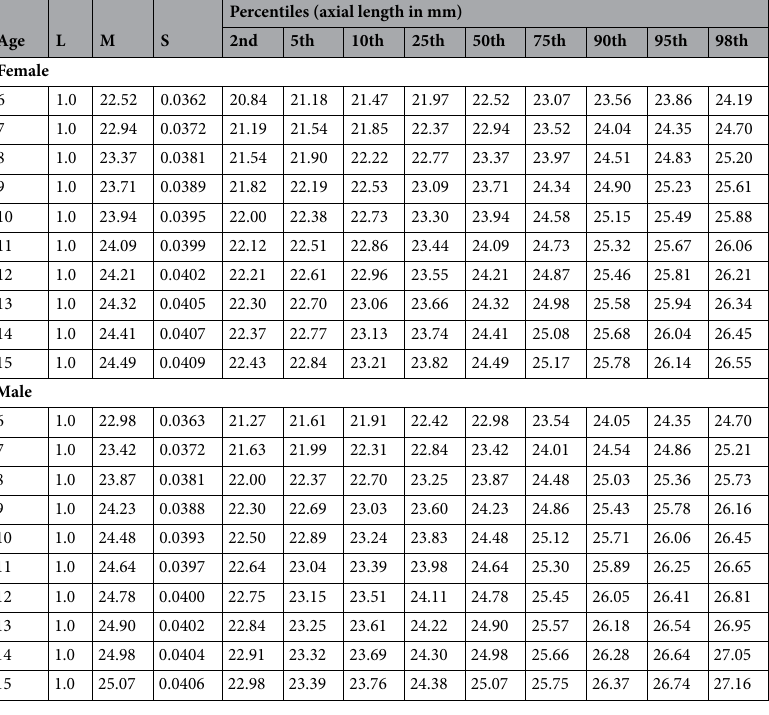
Table 2. LMS parameters and axial length percentiles in millimeters, as a function of age and gender.